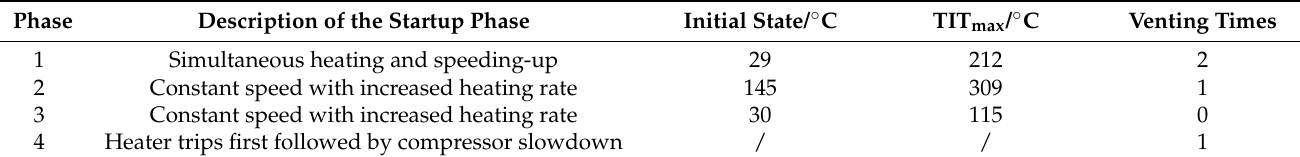
Table 5. Startup features of each